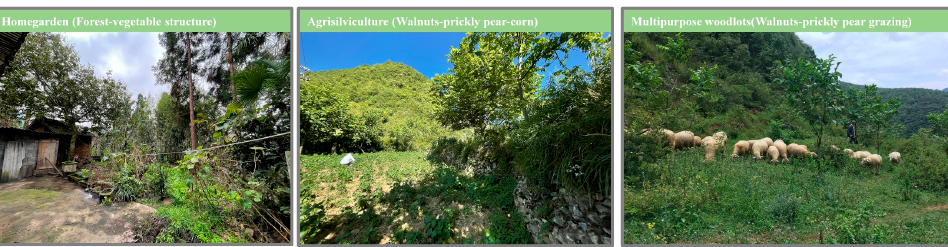
Figure 1. Study area. Salaxi was selected as the fi rst study area (hereafter referred to as BJ). The study area